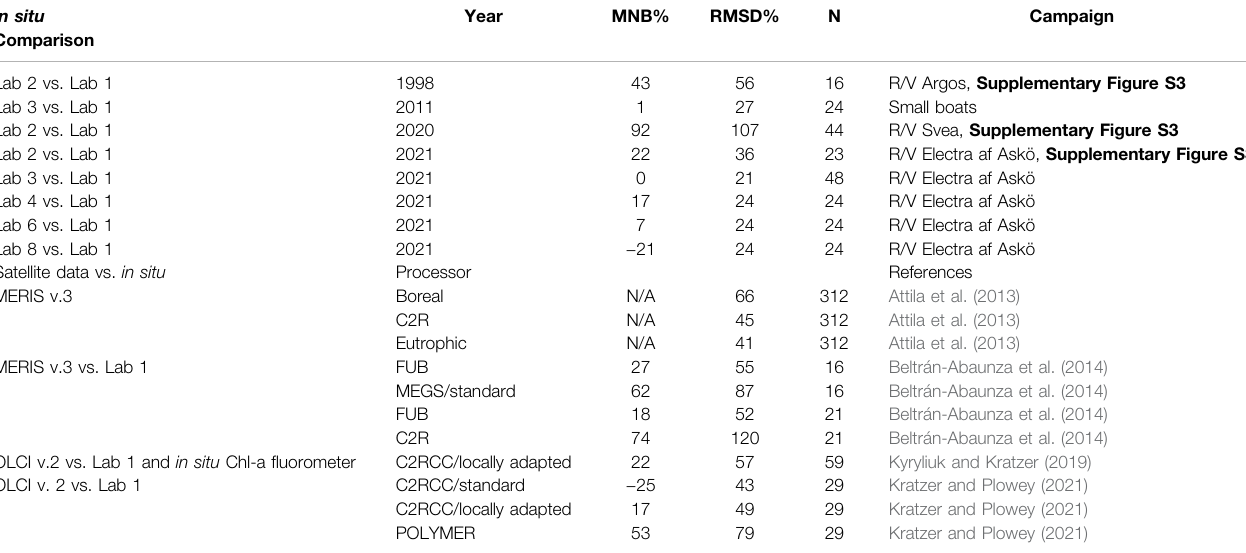
TABLE4| EvaluationofuncertaintiesintheChl-ameasurementsofLabs2,3,6,and8,eachvs.Lab1,aswellasuncertaintiesofvarioussatelliteChl-aproductsderivedfrom MERIS and OLCI vs. Lab 1. The best satellite processors have an MNB within 17 – 27% (in bold). In situ